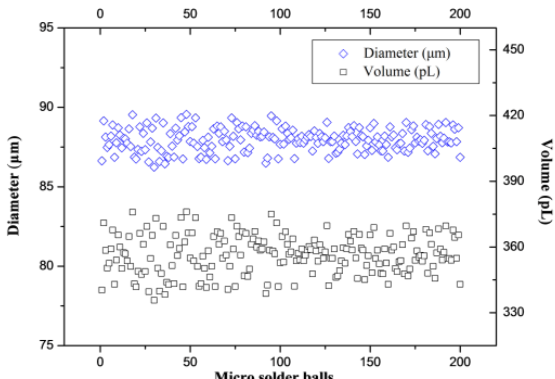
Figure 18. Measured diameters and volumes of 200 microsolder balls.